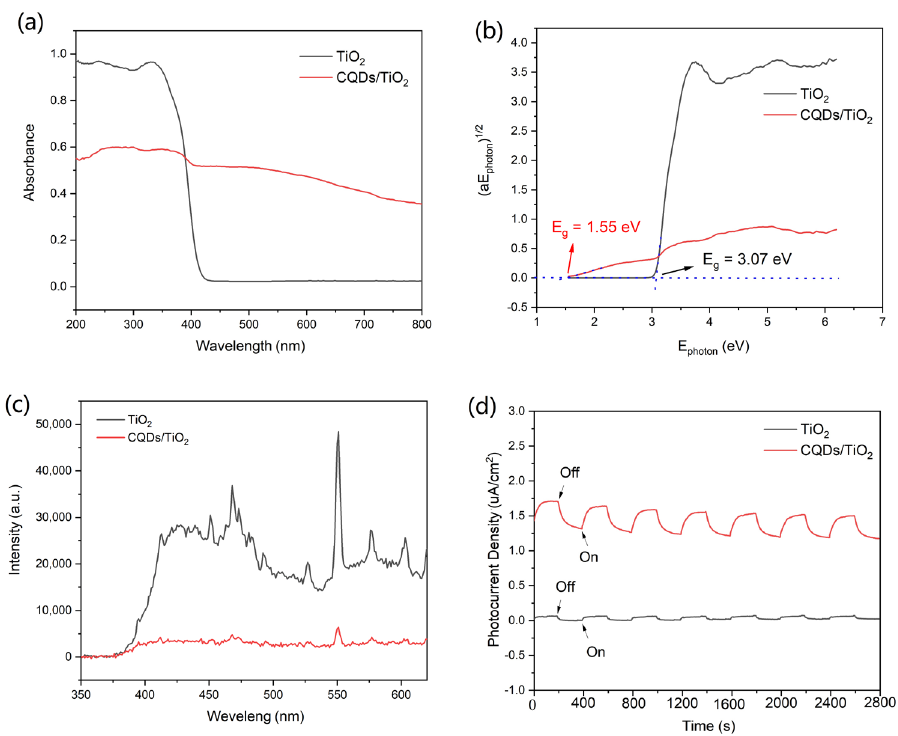
Figure 10. ( a ) The UV-VIS absorption spectra of CQDs/TiO 2 composite and pure TiO 2 ; ( b ) the (aE photon ) 1/2 vs. E photon curves of CQDs/TiO 2 composite and pure TiO 2 ; ( c ) the PL spectra of CQDs//TiO 2 composite and pure TiO 2 ; ( d ) the photocurrent response of CQDs/TiO 2 composite and pure TiO 2 .